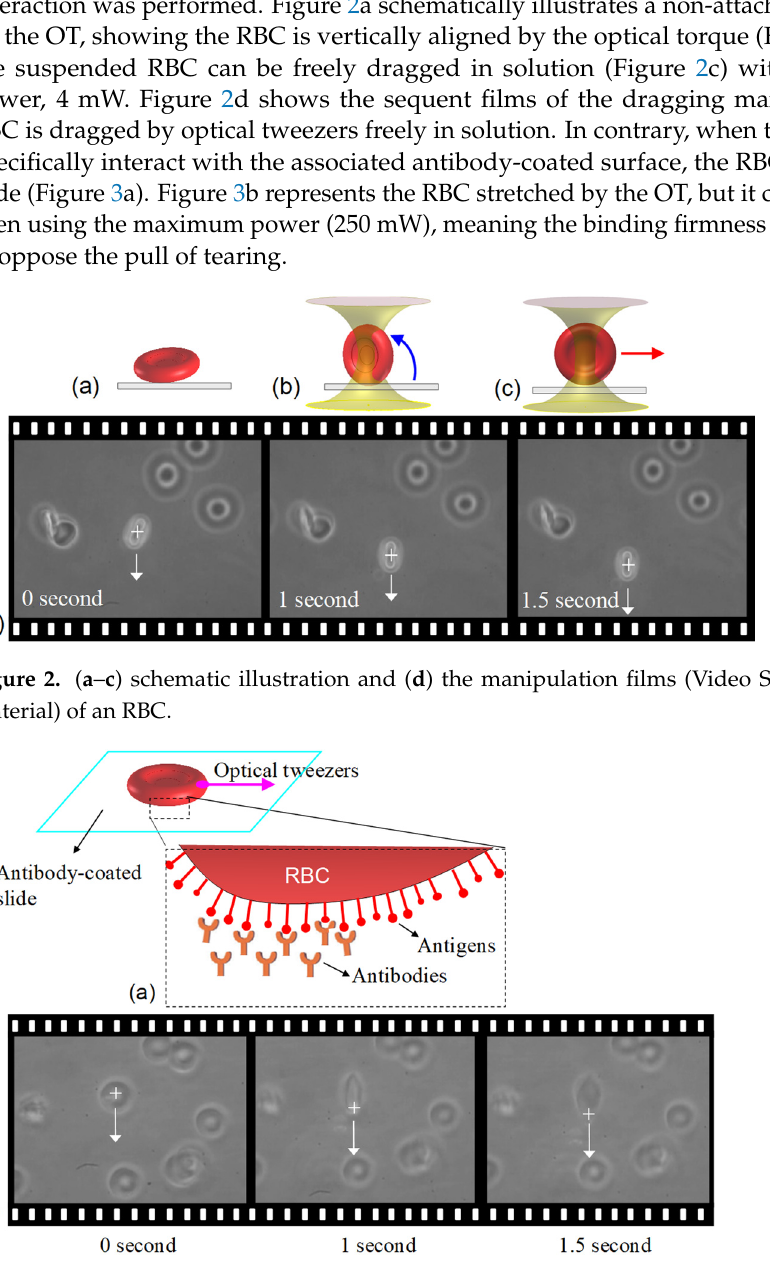
Figure 3. ( a ) Schematic illustration (not in scale) detailing RBC attachment to the antibody-coated surface. ( b ) RBC is torn off by OT but still attaches to the antibody-coated surface (Videos S2, Supplementary material).